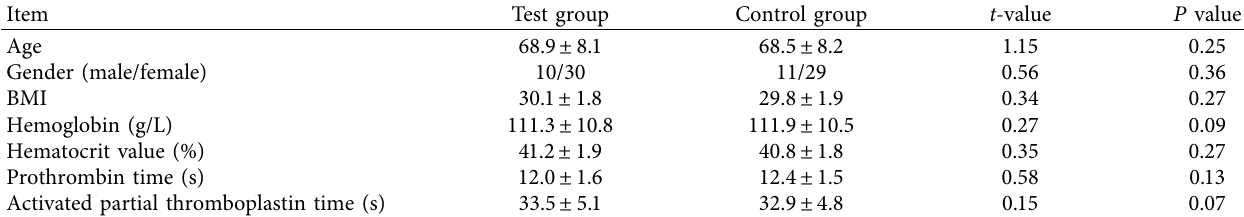
Table 1: Preoperative basic information between the two groups.